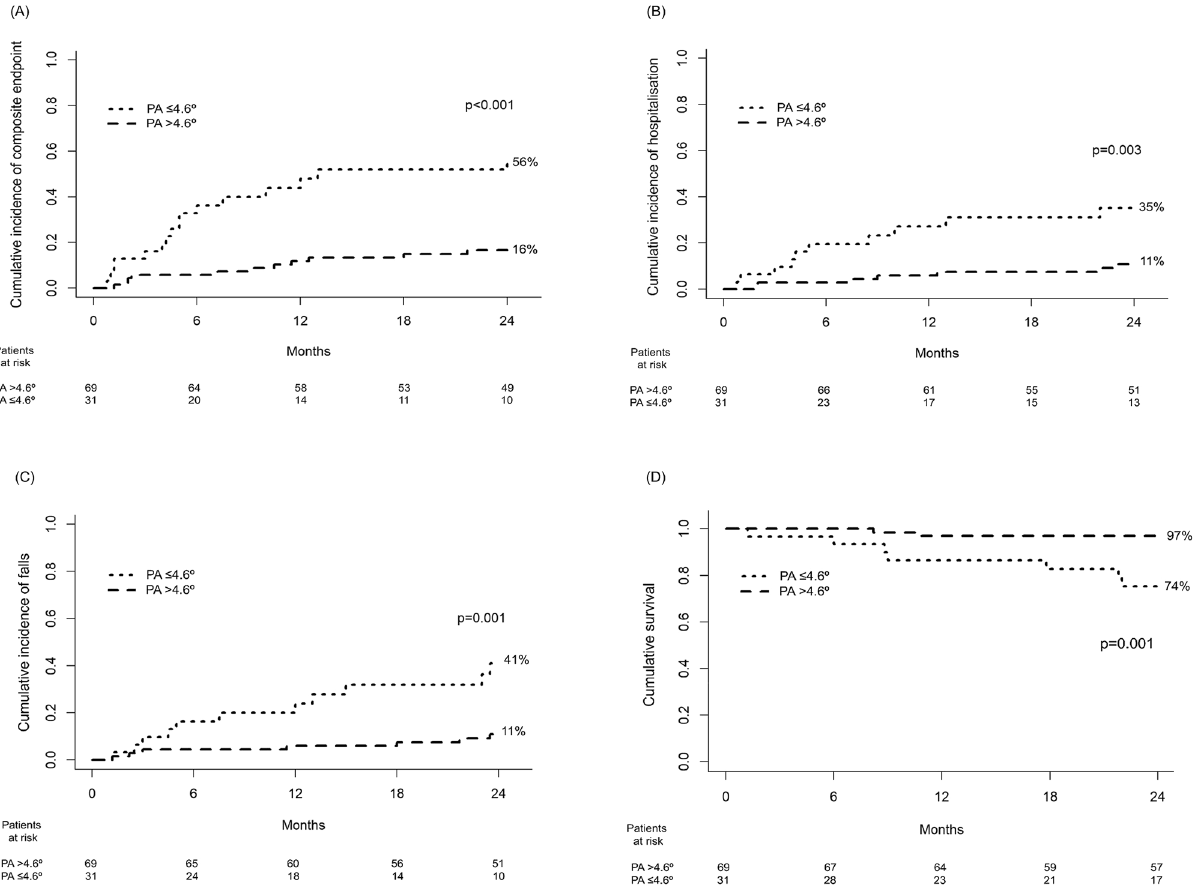
Figure 2. Probability of the composite endpoint (hospitalisation, admission to a long-term care centre, falls, or mortality) (A) , hospitalisation (B) and falls (C) , and survival (D) at 2-year follow-up in patients with phase angle (PA) ≤ 4.6° and patients with PA >